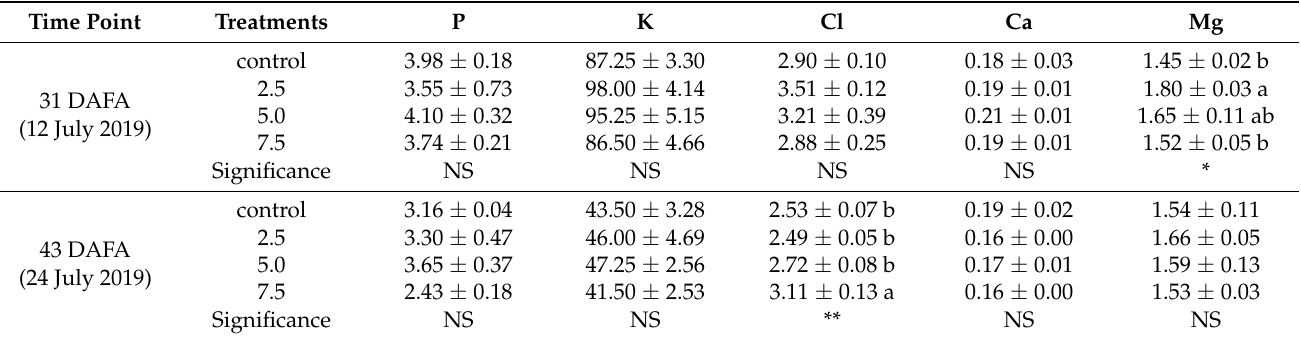
Table 4. Mineral nutrient analysis in tomato fruit (mg g − 1 dw) harvested 31 and 43 DAFA of sodium hypochlorite in an open soilless system at chlorine concentrations of 2.5, 5.0 and 7.5 mg L − 1